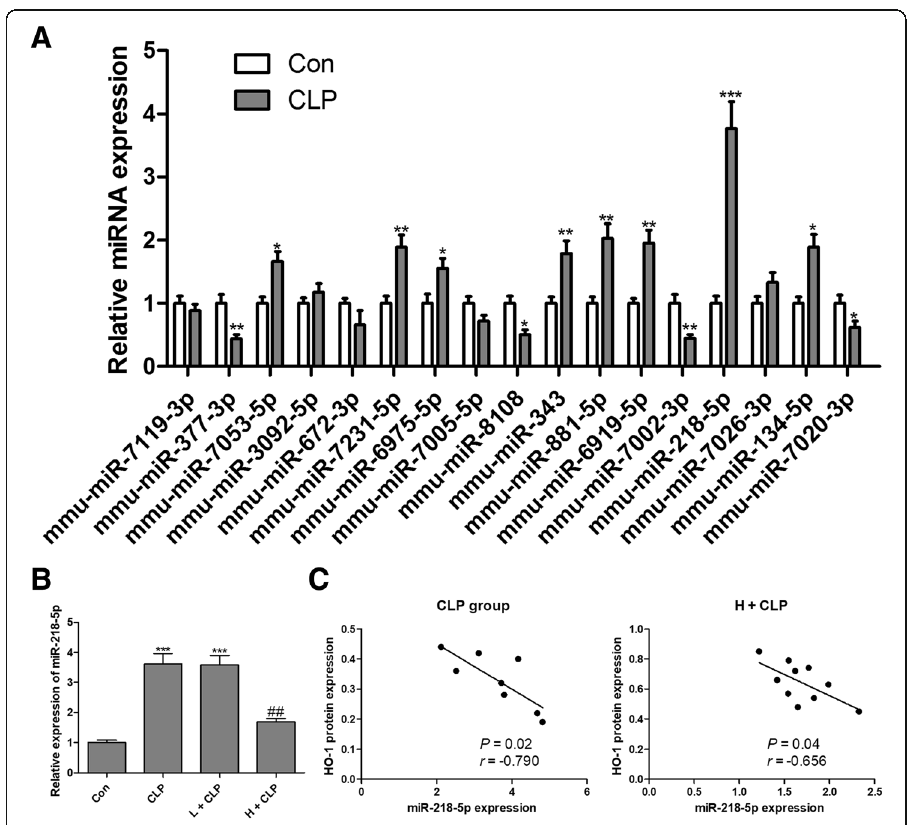
Fig. 5 MiRNA expression in the kidney from septic mice. HO-1-related miRNAs were predicted using online software TargetScan (www.targetscan.org) and miRDB (http://www.mirdb.org/miRDB/), and the expression levels of 17 miRNAs were measured by RT-qPCR assays ( a ). After treatment with honokiol, the expression of miR-218-5p was measured using RT-qPCR in the kidney ( b ). Spearman ’ s rank analysis was used to identify the correlation between HO-1 and miR-218-5p expression levels in the kidney of septic mice with CLP or CLP combined with honokiol treatment ( c ). Values are expressed as mean ± SEM, n = 10 in Con or H + CLP group and n = 8 in CLP or L + CLP group. * P < 0.05, ** P < 0.01, *** P < 0.001, versus control group; ## P <